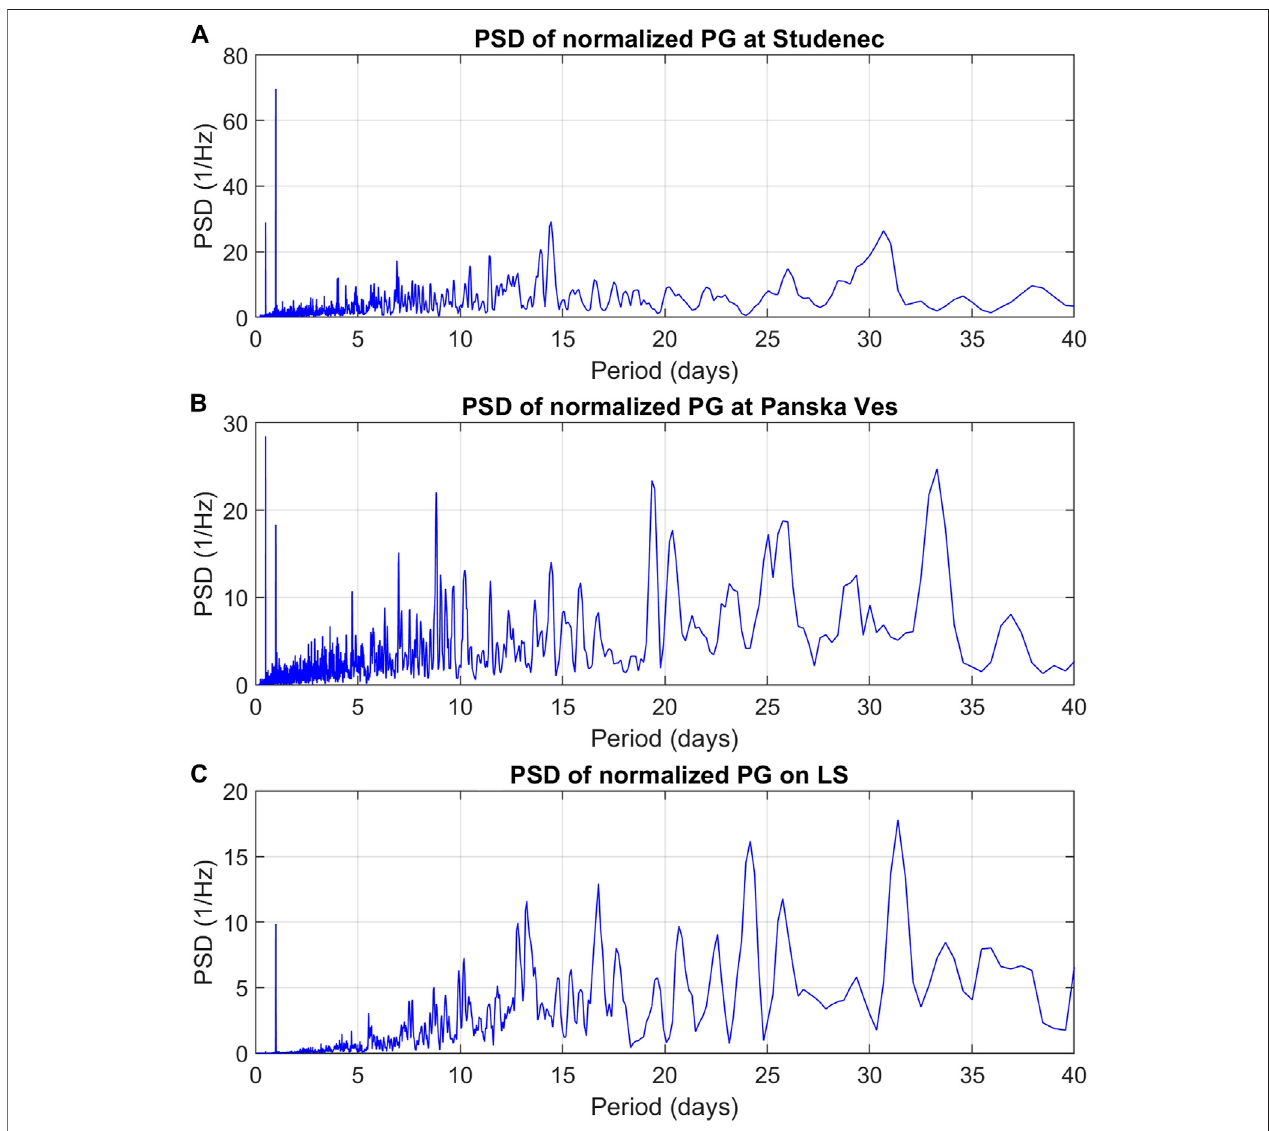
FIGURE 8 | Power spectral densities (PSD) of the normalized PG (proxy for fair weather) measured at Studenec (A) , Panská Ves (B) and on LS (C) .